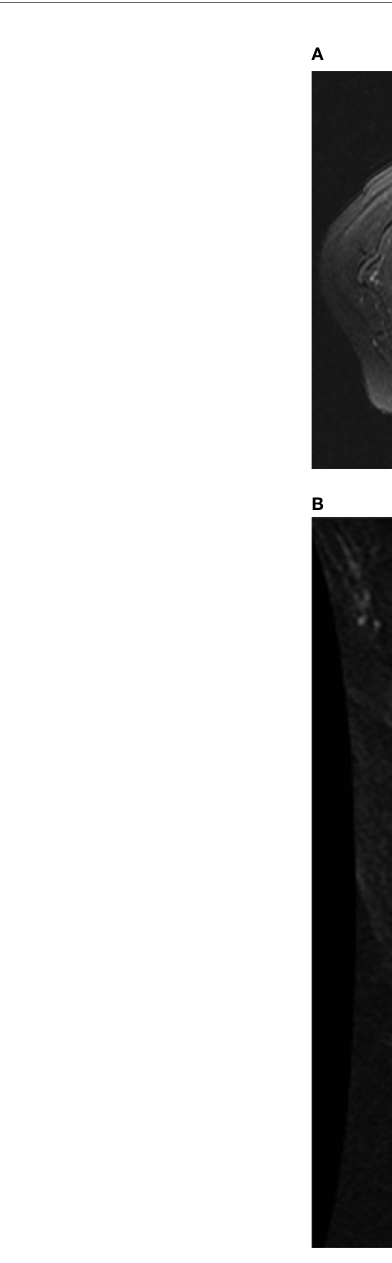
FIGURE 3 | Post-ablation scan: In both the transverse (A) and the oblique sagittal (B) views fsFRFSE T2WI scans, the ablation foci displayed as obvious low signals surrounded by ring-shaped high-signal shadows. In addition, the microwave antenna displayed as a strip of low signals, and a small amount of fl uid was seen in the pleural cavity adjacent to the